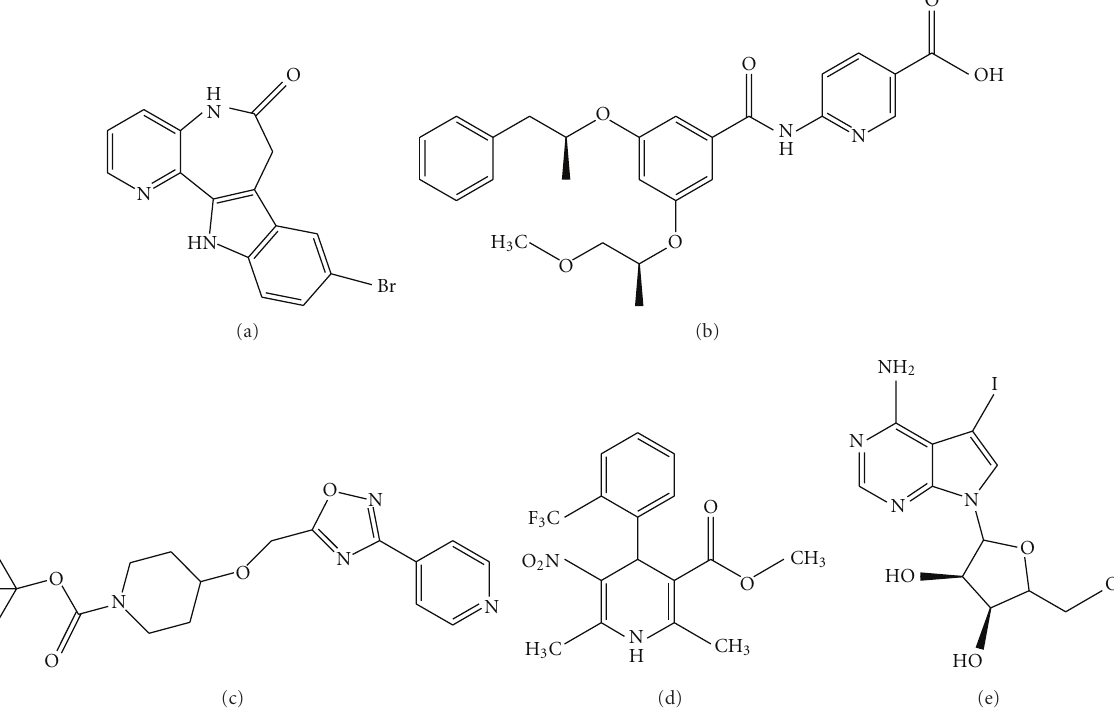
Figure 1: Chemical structures of small molecules reported to induce beta-cell proliferation. (a) 1-Azakenpaullone, a GSK-3 β inhibitor [47]. (b) GKA50, a glucokinase activator [51]. (c) PSN632408, a GPR119 agonist [52]. (d) Bay K 8644, an L-type calcium channel activator [53]. (e) 5-Iodotubercidin, an adenosine kinase inhibitor